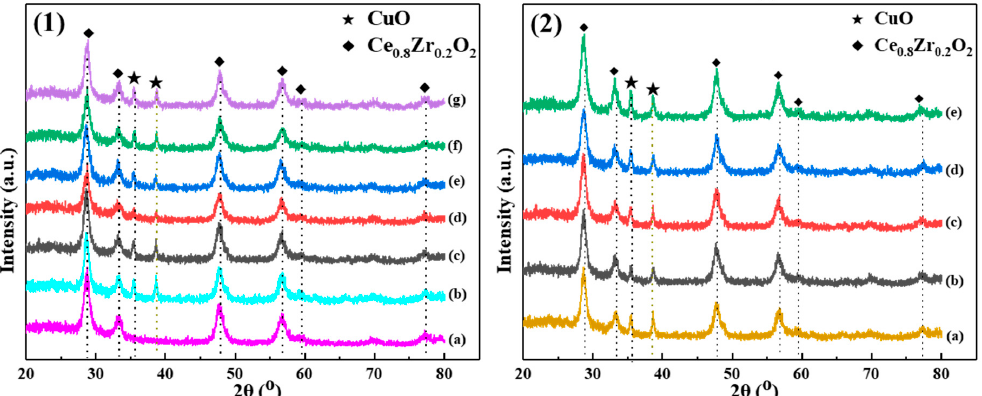
Figure 1. ( 1 ) XRD patterns of M-Ce80Zr20 and 15CuO-3MO x / M-Ce80Zr20 (MO x = La 2 O 3 , Fe 2 O 3 , PrO 2 , Sm 2 O 3 , MnO 2 ): ( a ) M-Ce80Zr20, ( b ) 15CuO / M-Ce80Zr20, ( c ) 15CuO-3Fe 2 O 3 / M-Ce80Zr20, ( d ) 15CuO-